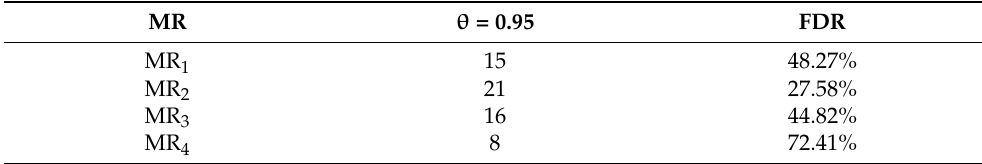
Table 7. Fault detection rate of T2-weighted images.